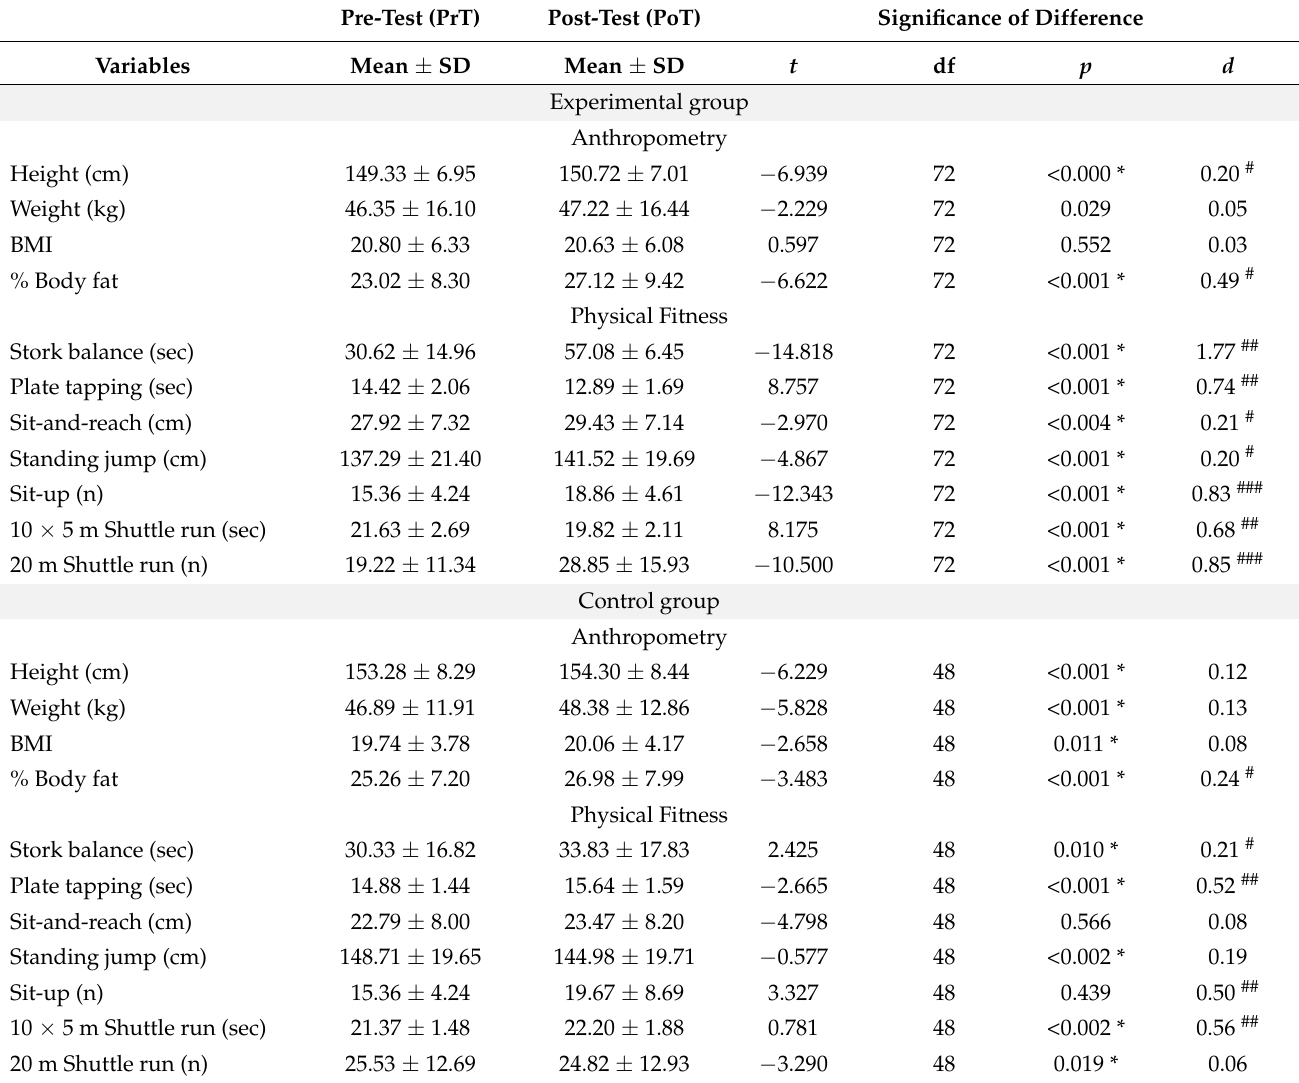
Table 3. Differences within the experimental and control group’s physical fitness levels during pre-and